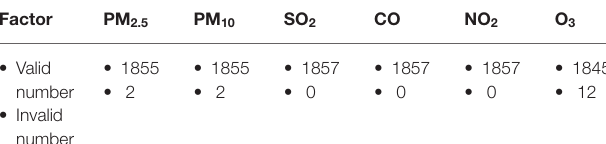
TABLE 2 | Valid number of each factor (Total 1,857